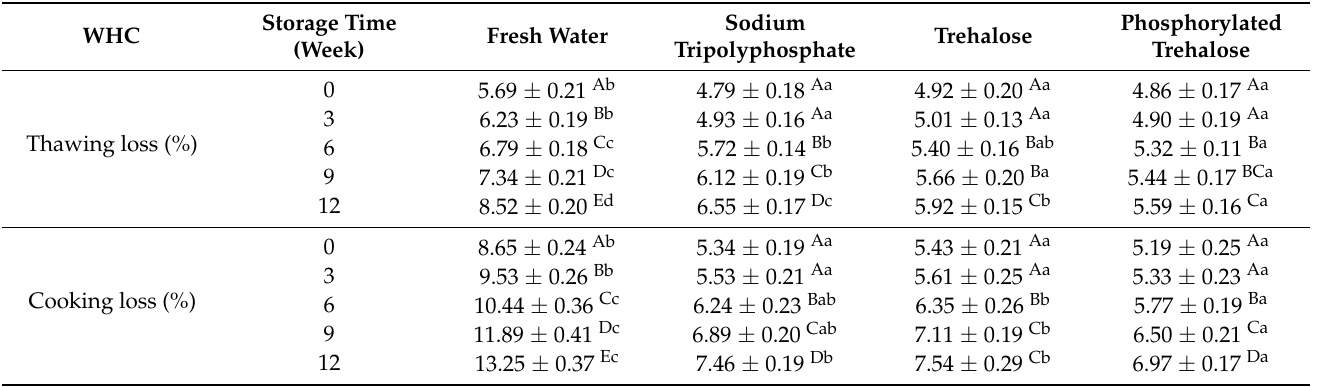
Table 1. Effects of fresh water, sodium tripolyphosphate, trehalose, and phosphorylated trehalose on the thawing loss and cooking loss of peeled shrimp during frozen